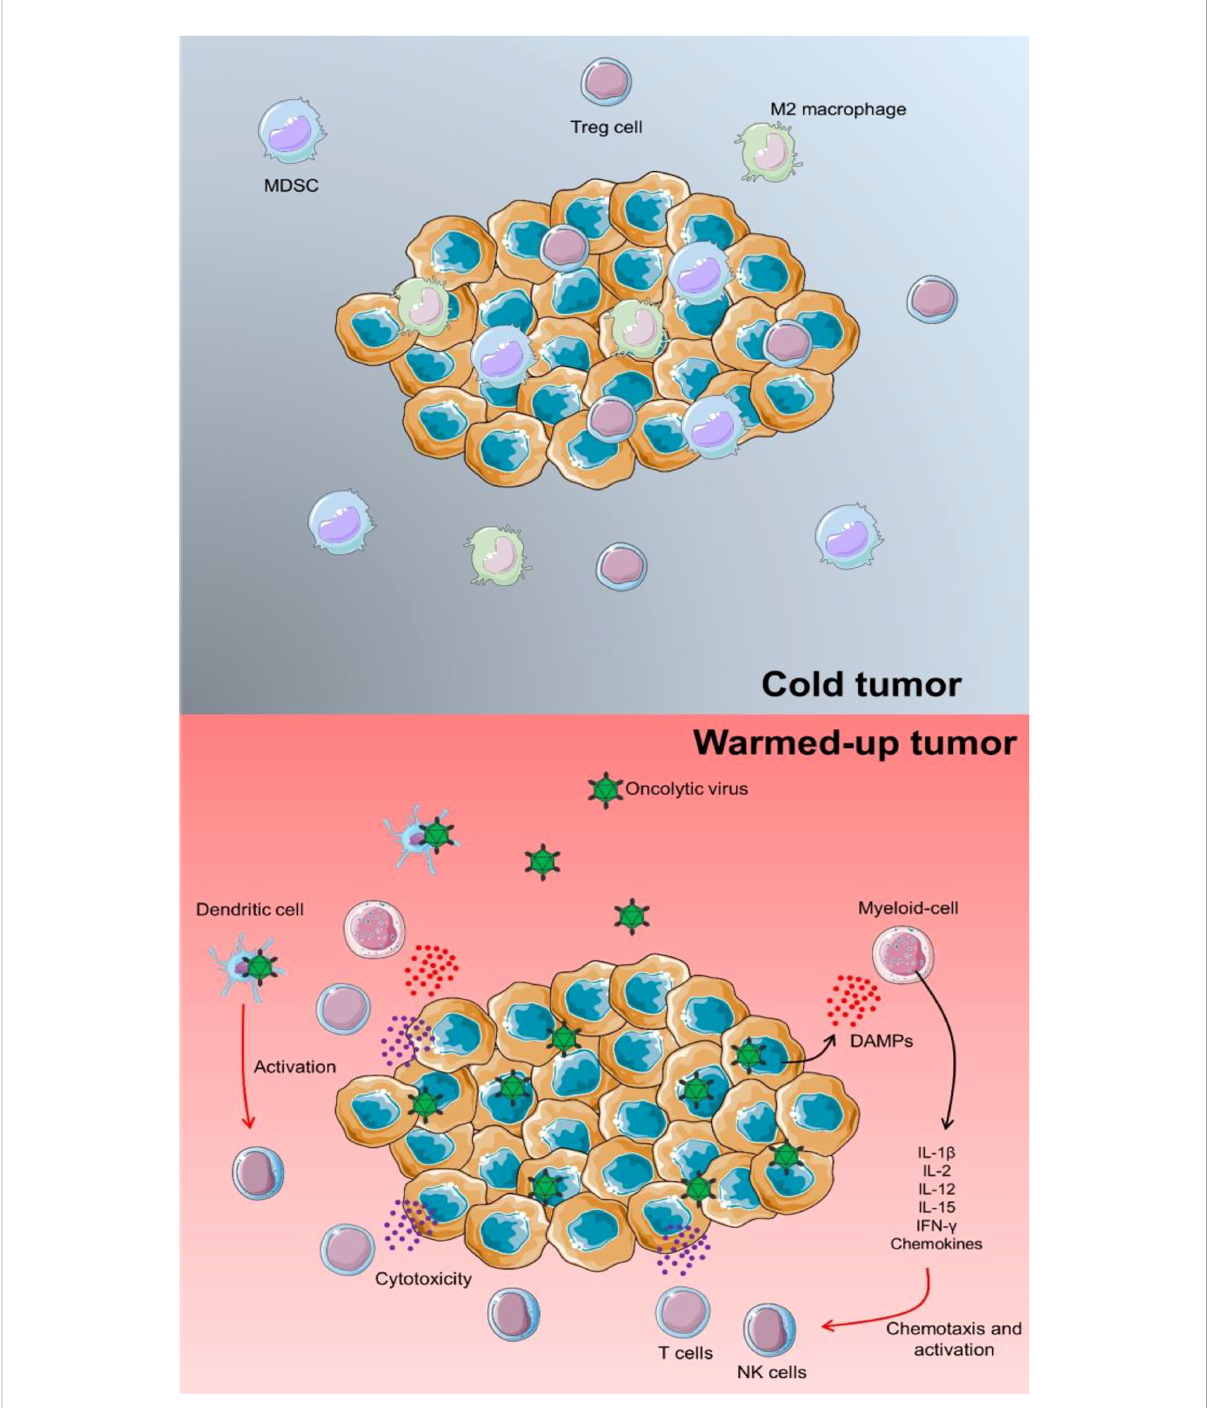
FIGURE 1 TME warming up via OV infection. In a cold tumor, several immunosuppressors could inhibit the proper anti-tumor activity of immune cells. In this case, tumorigenicity could be progressed and lead to the development of other cancer features. Proceeding an OV infection, releasing pro-in fl ammatory cytokines and chemokines could activate chemotaxis of lymphoid cells such as T cells and NK cells to enhance the immune response against tumor progression. Besides, by direct infection of DCs via OVs, these immune cells could trigger NK cells and support a speci fi c cytotoxic